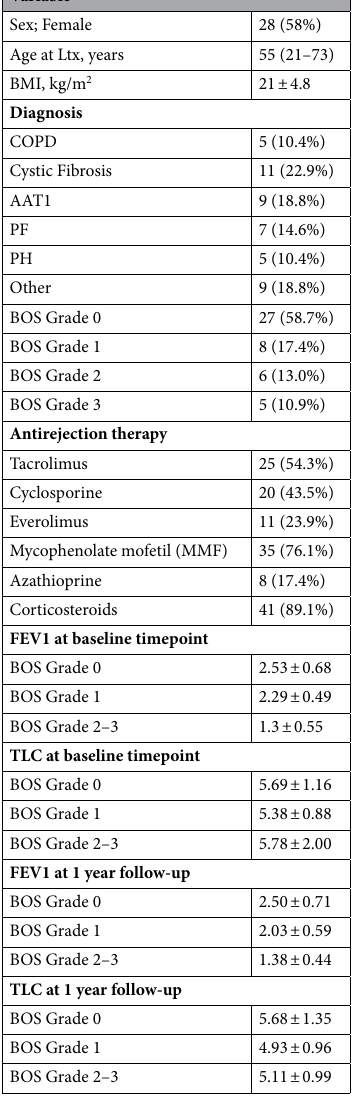
Table 1. Patient characteristics (n = 46). Eligible patients included those in stable condition, without ongoing infection, who were ≥ 2 years and did not have RAS. Numbers are expressed as the mean x ± SD when parametric, median x (range) when nonparametric or numerical values (%). Ltx = Lung transplantation; BMI = Body Mass Index; COPD = Chronic obstructive pulmonary disease; A1ATD = α-1-antitrypsin deficiency; PF = Pulmonary fibrosis; PH = pulmonary hypertension; Other includes bronchiectasis, sarcoidosis, and graft-vs-host disease; BOS, bronchiolitis obliterans syndrome; FEV1 = forced expiratory volume in 1 s; TLC = total lung